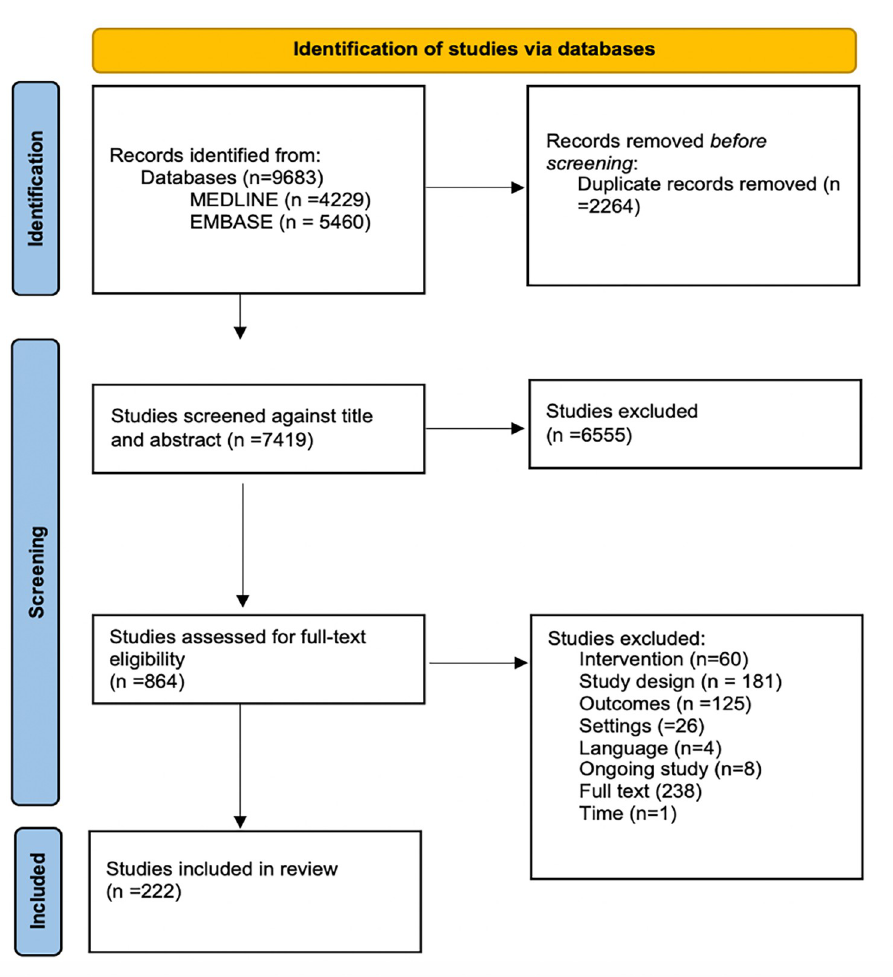
Fig 1. PRISMA flow chart. Intervention refers to studies excluded because they studied the implementation of interventions that did not meet the eligible criteria. Study design refers to studies excluded because they used study designs that did not meet eligibility criteria (e.g., nonempirical studies including reviews and commentaries). Outcomes refer to studies excluded based on not having focused on relevant implementation outcomes. Settings refer to studies excluded because they were not conducted in LMICs. Full text means that studies were excluded because full text was not available. Time refers to studies that were excluded because they were published before/conducted before